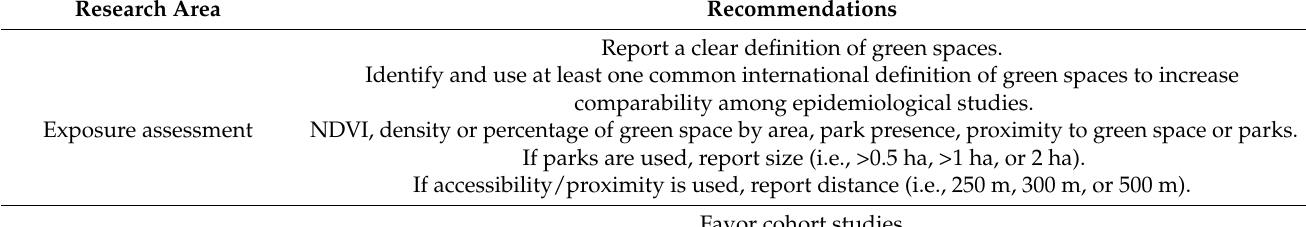
Table 2. Recommendations for future research on green spaces and health in Latin America. Research Area